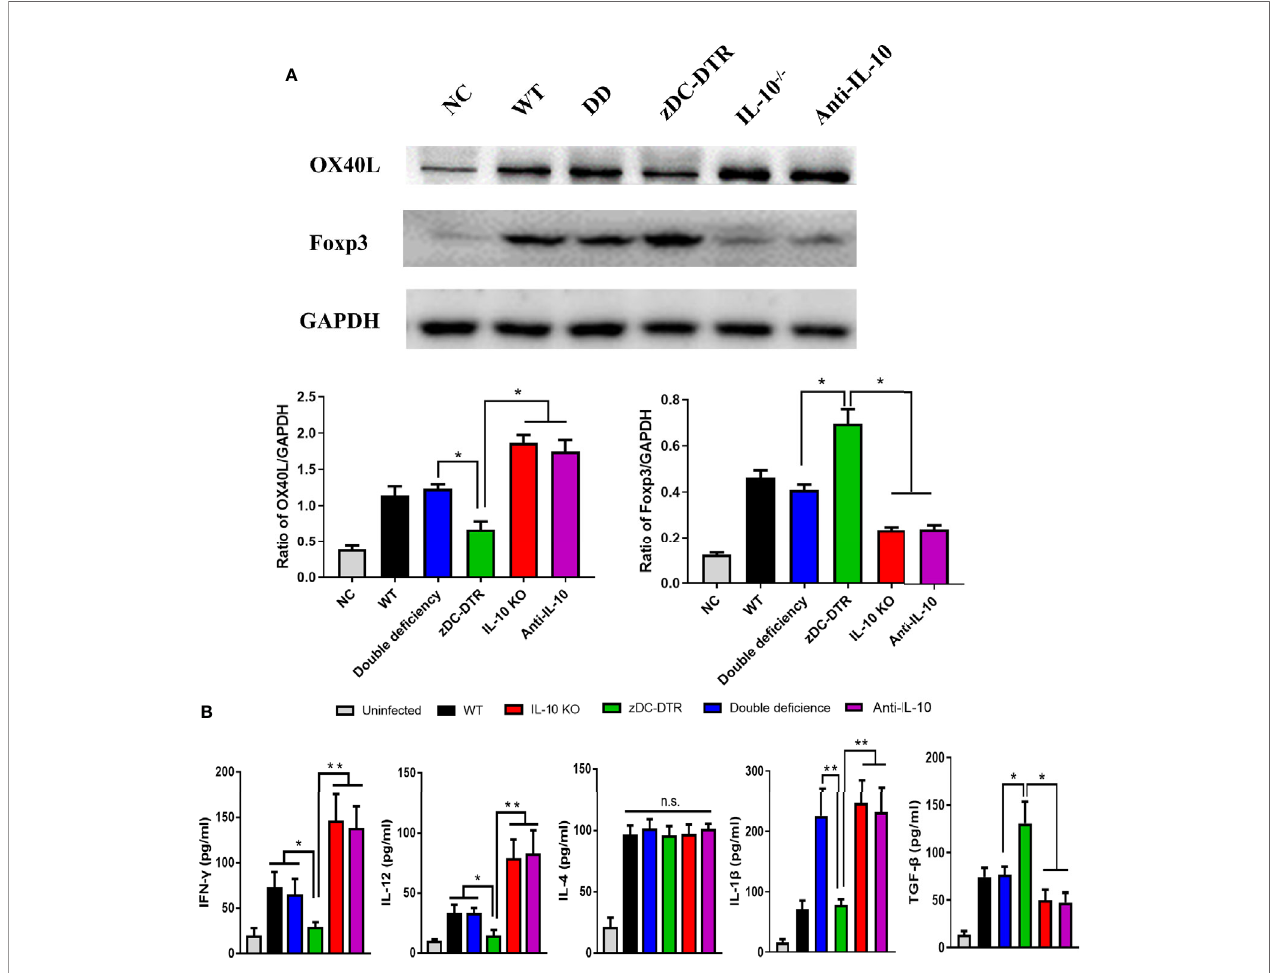
FIGURE 6 | Detection of the OX40L receptor, Treg expression, and cytokine secretion in the co-culture system. (A) Lysis of BMDCs using NP40 reagents, and detection of OX40 ligand (OX40L) and FOXP3 expression by Western blotting. GAPDH was used as the internal control. Higher OX40L expression was observed in the IL-10 − / − , anti-IL-10, and DD groups than the zDC-DTR group ( P <0.05). In contrast to OX40L, higher levels of FOXP3 were observed in the zDC-DTR group than the other groups at 72 hpi ( P <0.05). (B) Quanti fi cation of the levels of cytokines (IFN- g , IL-12, IL-4, TGF- b , and IL-1 b ) in the supernatants using commercial ELISA kits at 72 hpi. All data were expressed as the mean ± SD (n=5 per group). Higher IFN- g and IL-12 levels were observed in the IL-10 − / − , anti-IL-10 ( P <0.01), and DD groups ( P <0.05) than the zDC-DTR group. Moreover, higher TGF- b levels were detected in the zDC-DTR group compared to other groups. Signi fi cantly higher IL-1 b levels were observed in the IL-10 − / − , the anti-IL-10, and the DD groups compared to the WT and the zDC-DTR groups. No signi fi cant differences were determined in IL-4 secretions among the groups. The differences were analyzed by ANOVA (* P <0.05, ** P <0.01, n.s., no statistical signi fi